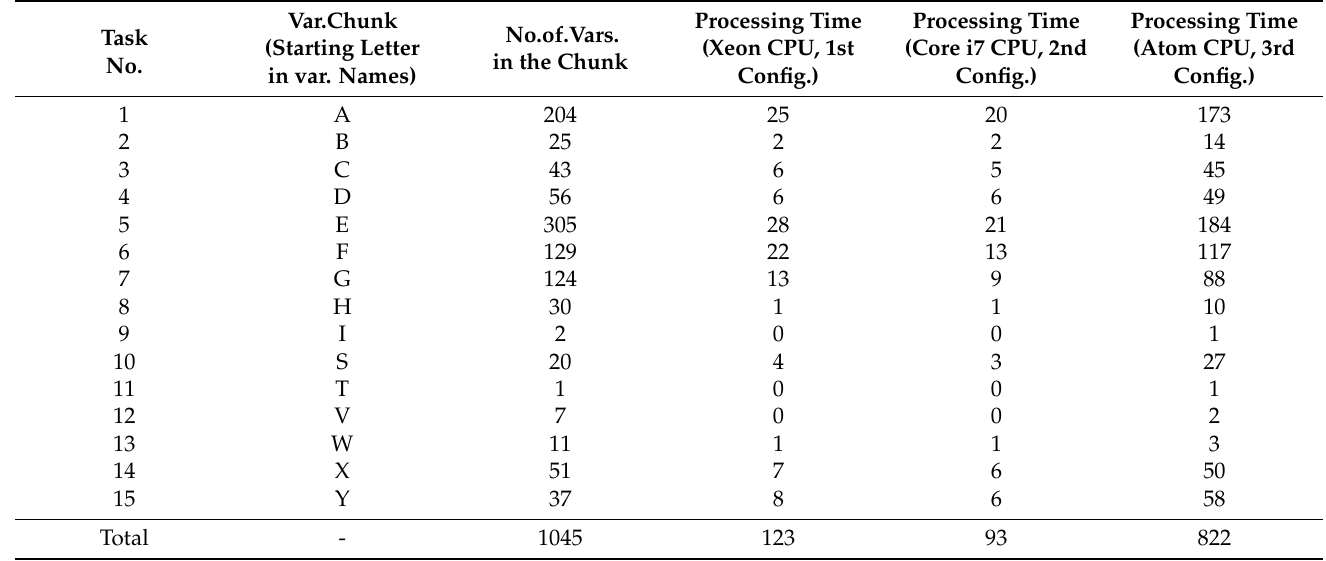
Table 2. The best execution time (approximation in sec.) of PCDM (single logical core) on variable chunks as depending on the starting letter in the